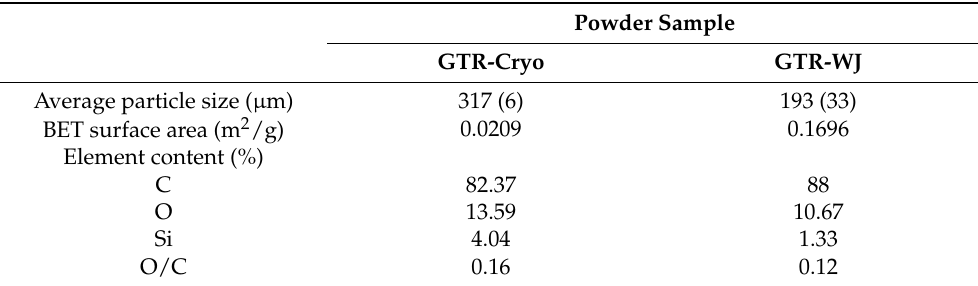
Table 2. Average particle size, BET surface, and surface relative element content of the GTR obtained with cryogenic and water jet technologies.